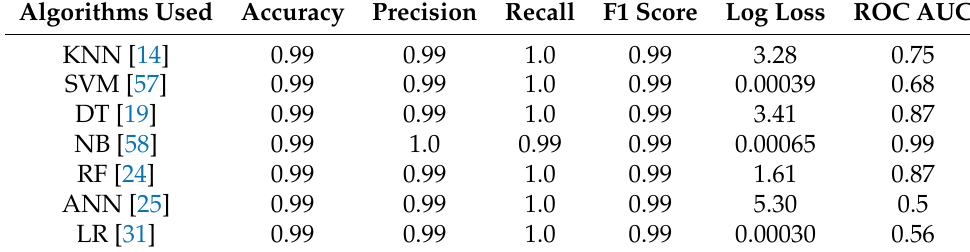
Table 37. DoS UDP